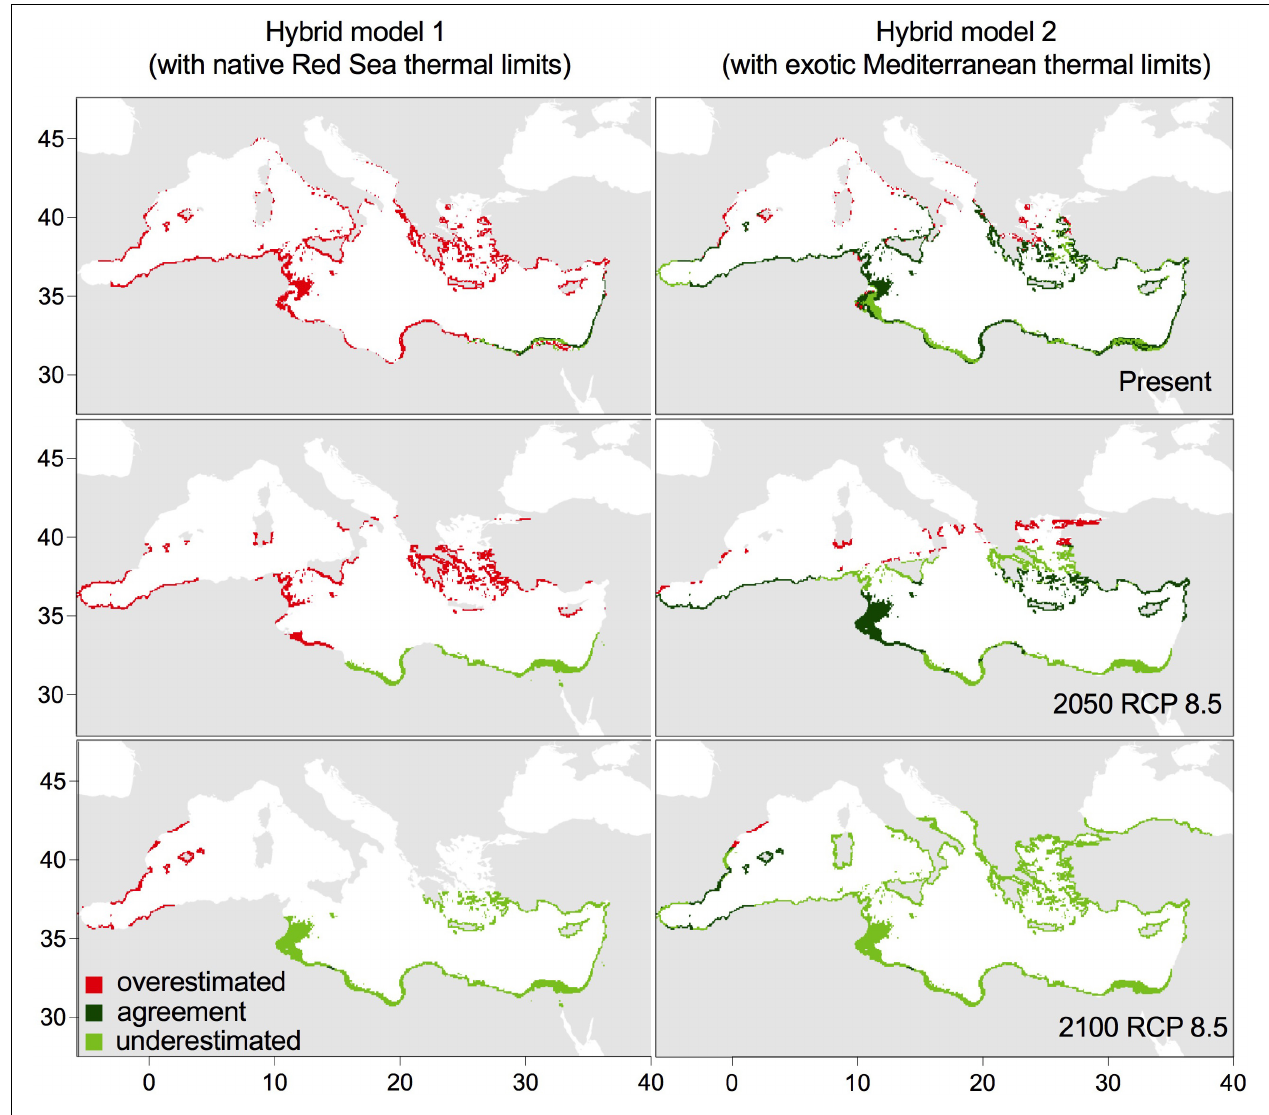
FIGURE 5 | Predicted occurrence of Halophila stipulacea according to the hybrid model 1 (based on native Red Sea thermal limits; 17–36 ◦ C) and the hybrid model 2 (based on exotic Mediterranean thermal limits; 14–36 ◦ C) under present conditions and 2 different climate change scenarios in the Mediterranean